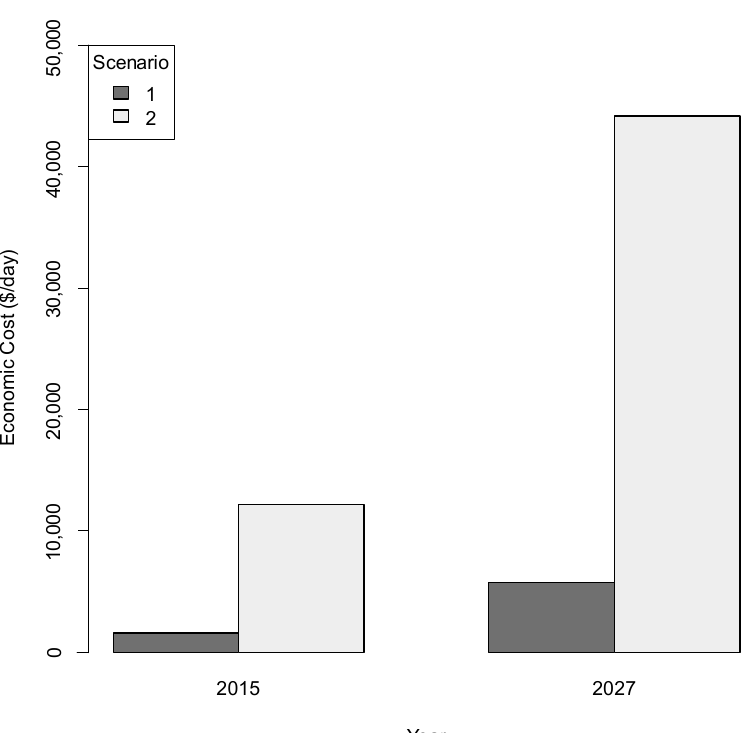
Figure 3. Economic cost per day due to the closure of the bridges.